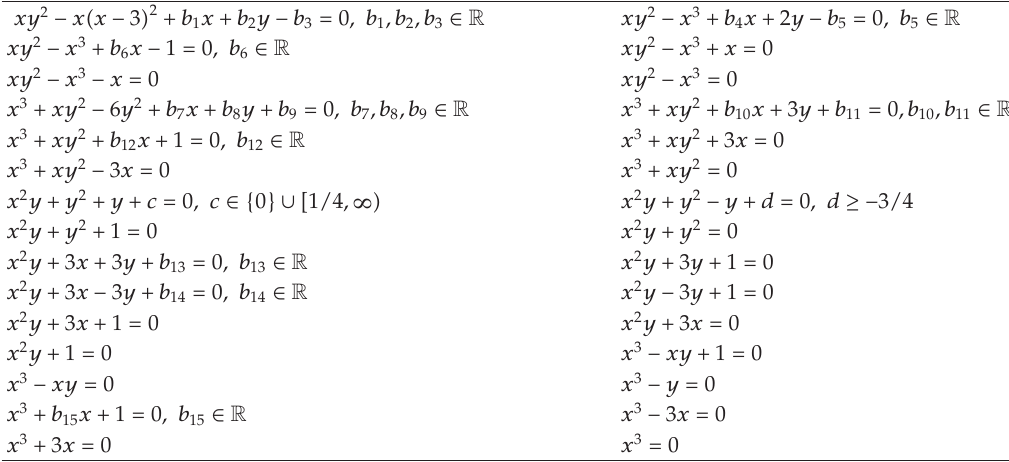
Table 4: Real polynomials which are not Hessian